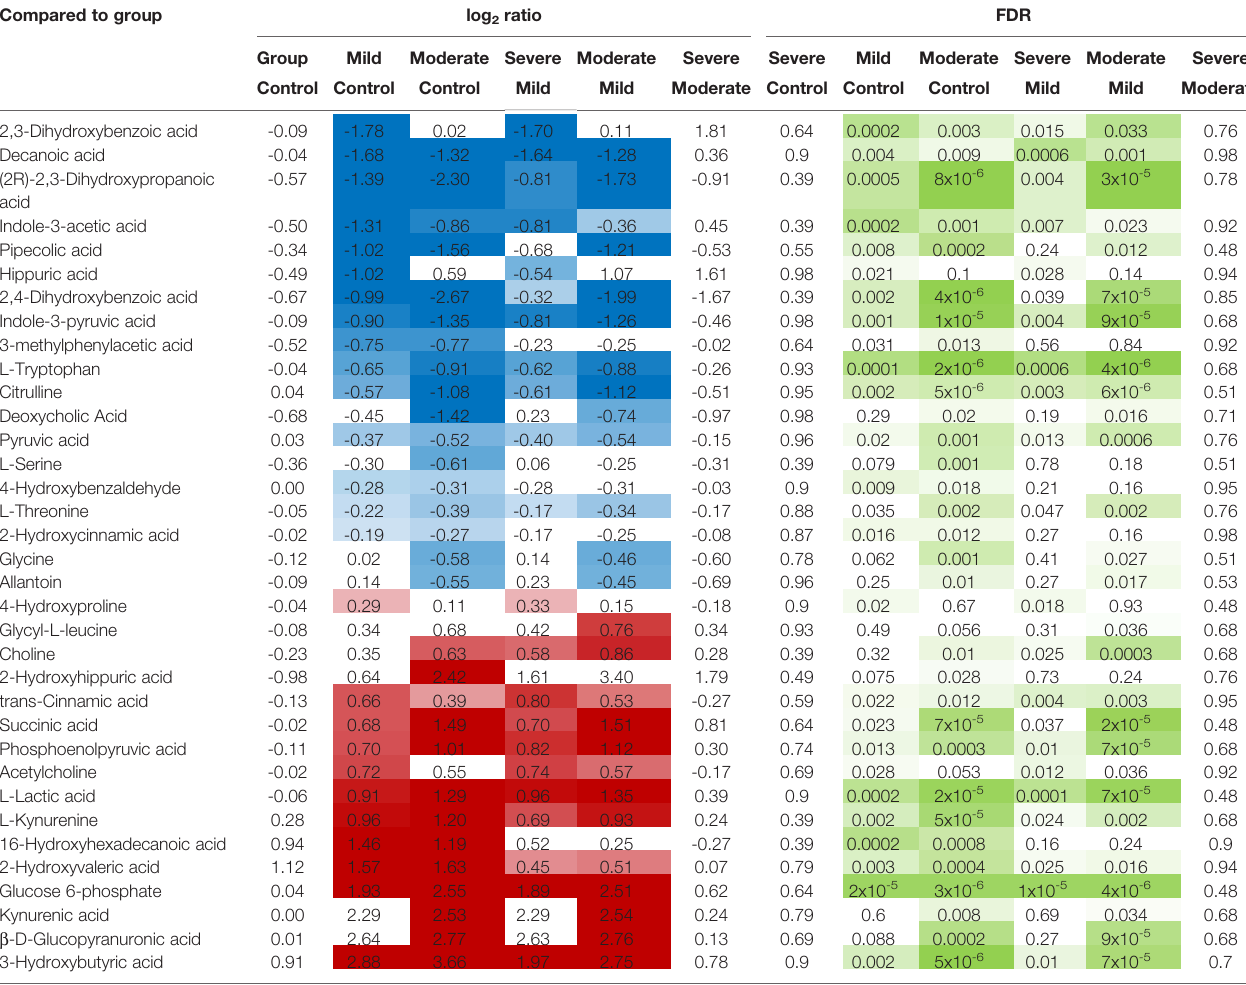
Red shades indicate upregulation, with darker shades indicate stronger upregulation. Blue shades indicate downregulation, with darker shades indicate stronger downregulation. Green shades indicate signi fi cant FDR, with darker shades indicate stronger